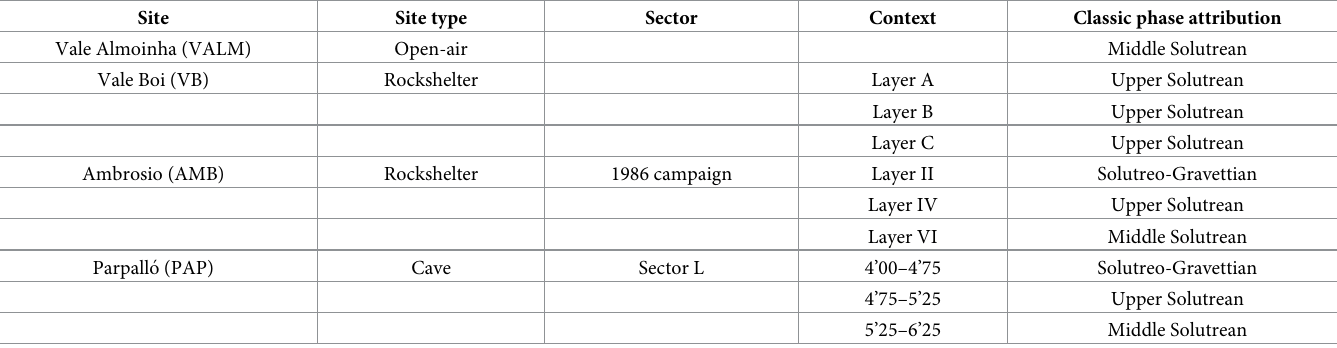
Table 2. Sampled sites, sectors and litho-stratigraphic contexts used in this study.